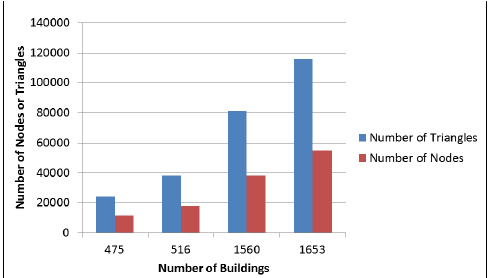
Figure 12: Node and Triangle to Building Count Ratios rendering time for the LoD 1/2 tests, as well as increased num- bers of nodes and triangles. The triangulation algorithm used to prepare the datasets was that provided by Safesoft’s FME product (SAFE Software, 2013) and may have generated a larger number of triangles than would be produced using other methods.